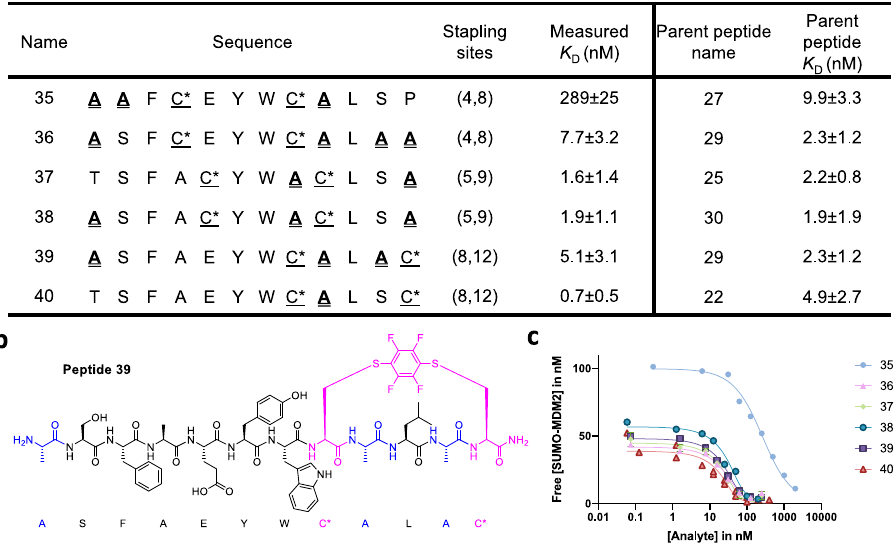
Fig. 5 Per fl uoroaryl-stapled and alanine-substituted peptides demonstrate high-af fi nity binding. a Per fl uoroaryl-stapled and alanine-substituted peptides 35 – 40 with low nanomolar binding af fi nity were generated at tolerable ( i, i + 4) stapling sites (Fig. 3c). b Structure of peptide 39 , alanine is colored in purple and stapling sites are colored in blue. c Example competition binding curves of peptides. C* = cysteine stapled with hexa fl